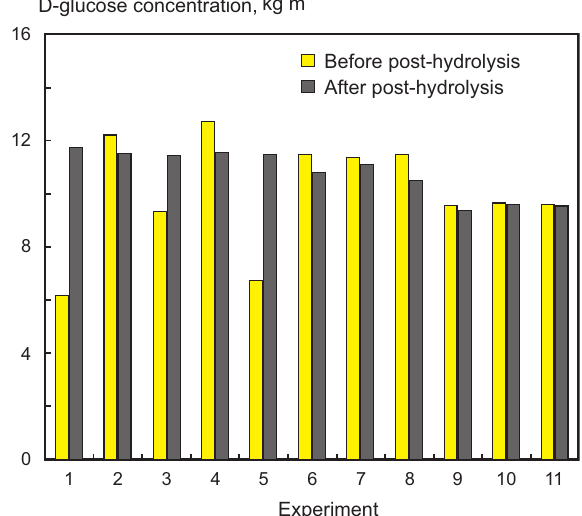
Figure 3. Response surfaces obtained for X C (%) by the model for (M) greater fraction; (m) smaller fraction; (1) t = 30 min; (2) t = 60 min; (3) t = 90 min. T and C values are coded.